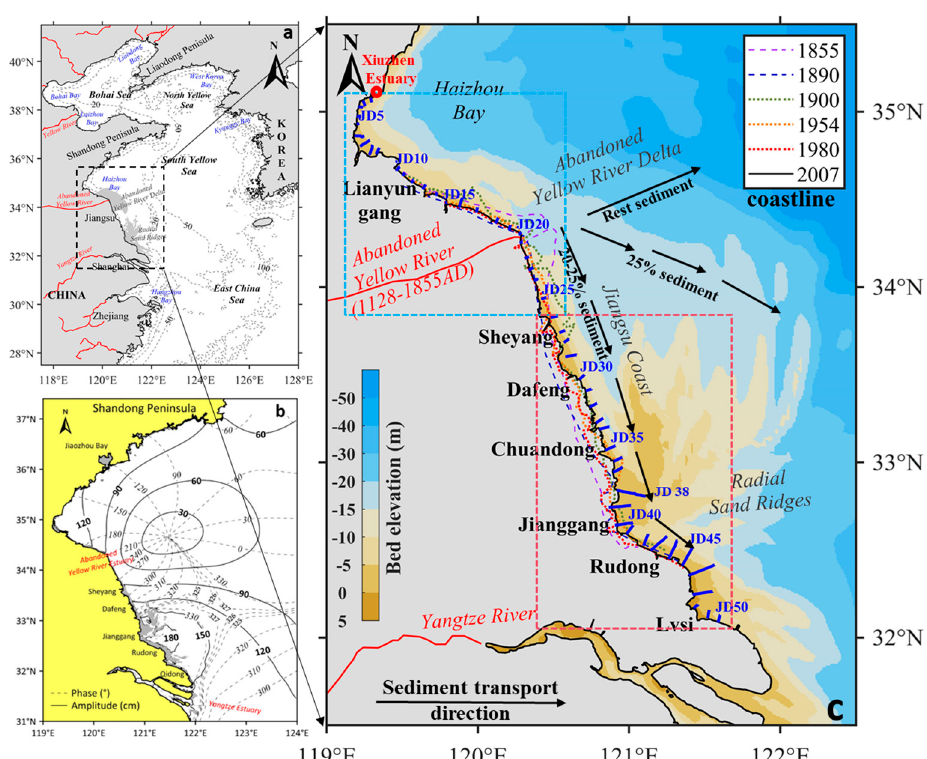
Figure 2. Map of the Bohai Sea, Yellow Sea and East China Sea ( a ). Subplot ( b ) shows the co-tidal charts of the M2 constituent for the southern Yellow Sea. Amplitude is shown in cm, and phase in degrees (from [23]). Subplot ( c ) indicates the Jiangsu Coastline evolution from 1855 to 2007, transport pattern of the sediment eroded from the Abandoned Yellow River Delta and the location of measured profiles. The locations of the Abandoned Yellow River Delta and the Radial Sand Ridges are labelled in ( a ), and the historical shoreline location in ( c ) is collected from [24], in which there is a detailed description of the shoreline data.